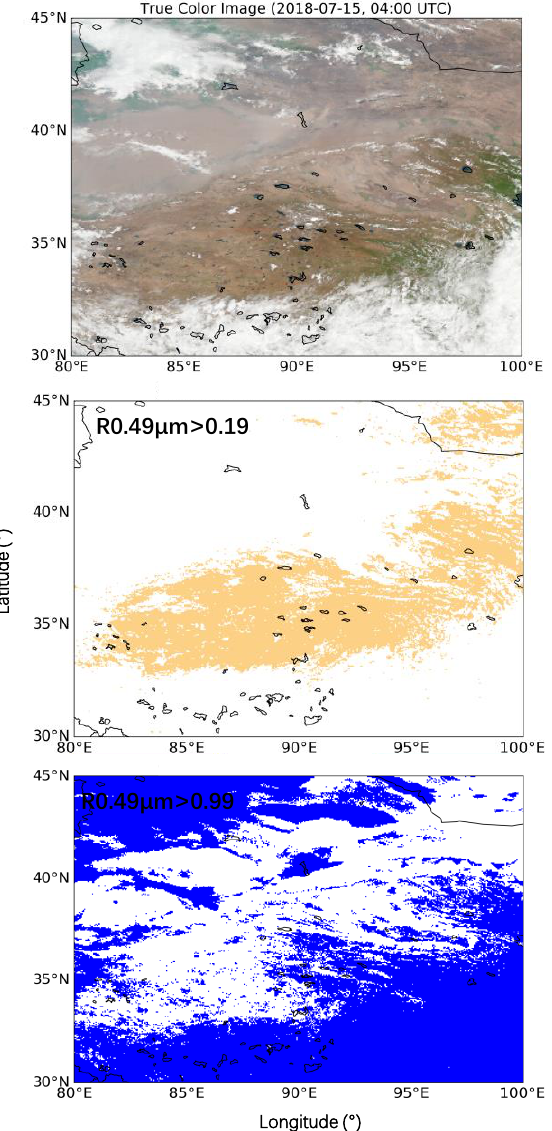
Figure 3 a) True-color image of 15 July 2018; b) the bright surface detected with test of R0.46; C) the cloudy regions detected by R0.86/R1.6.